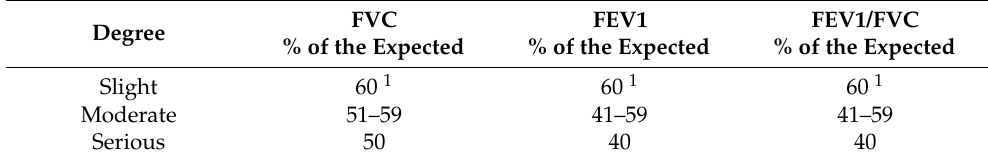
Table 1. Classification on the degree of obstruction based on FVC, FEV1 and FEV1/FVC values [11]. Degree